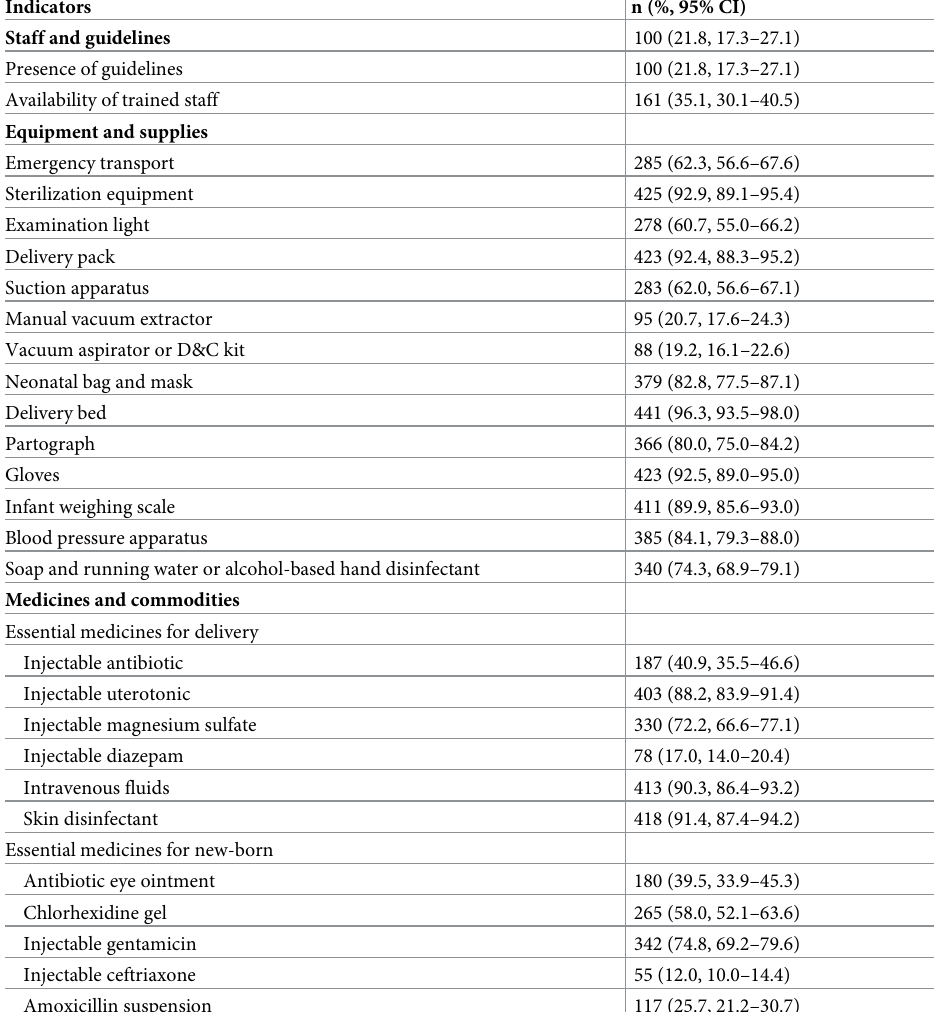
Table 3. BEmONC services readiness among surveyed health facilities (n =